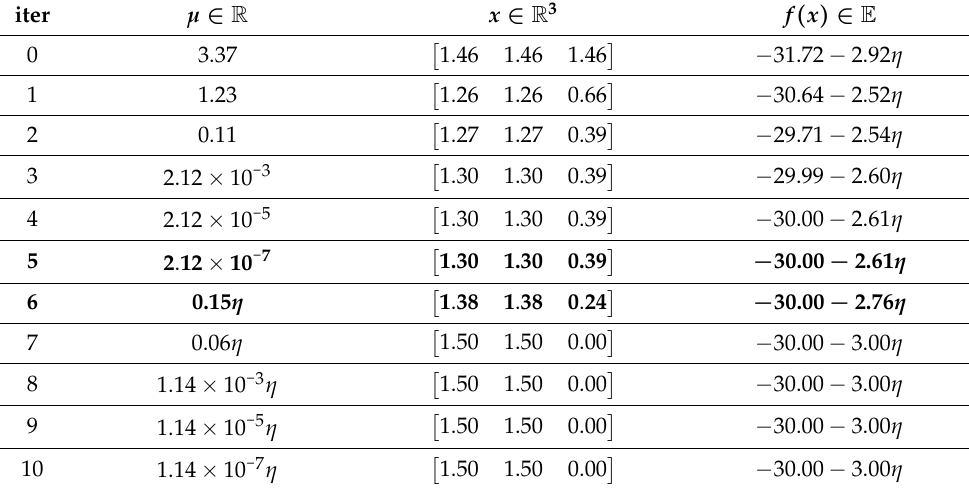
Table 3. Iterations of the NA-IPM solving the problem in